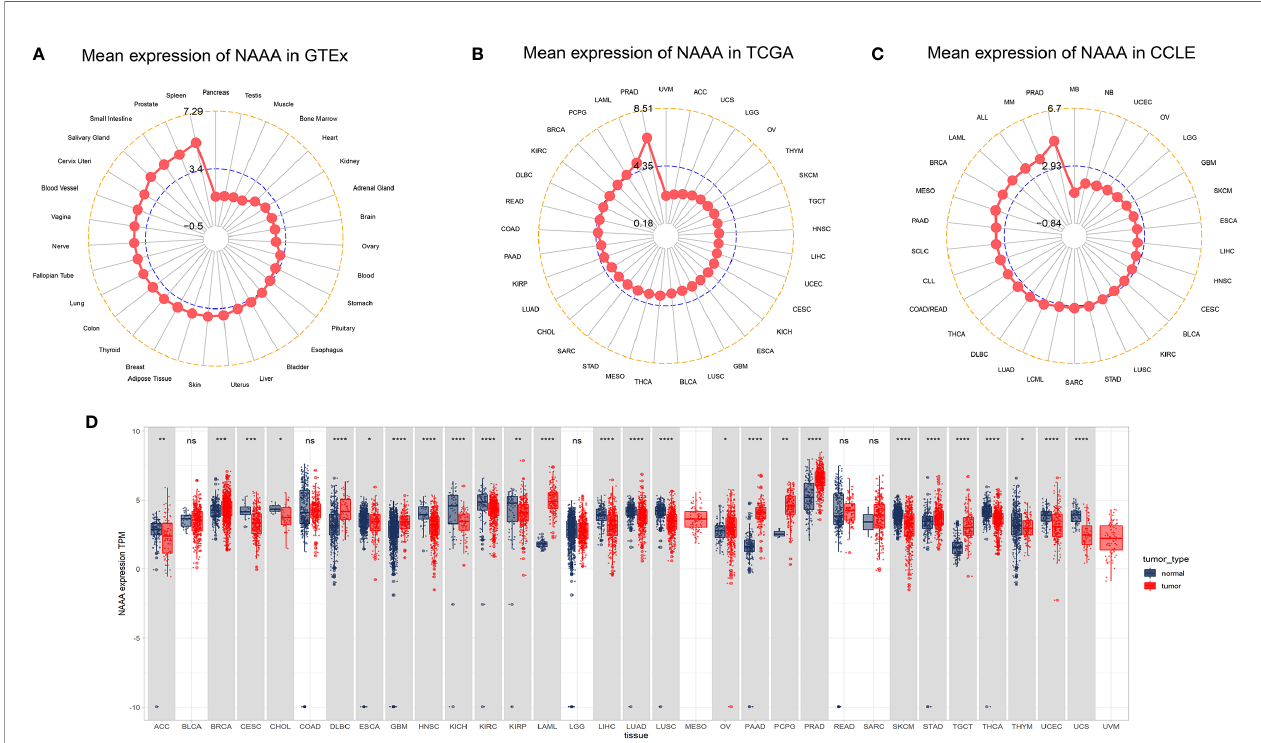
FIGURE 1 | NAAA mRNA expression levels in pan-cancer. (A) NAAA expression levels in normal tissues from GTEx database. (B) NAAA expression levels in tumor tissues from TCGA database. (C) NAAA expression levels in tumor cell lines from CCLE database. (D) NAAA expression difference between tumor tissues from TCGA database and normal tissues from the GTEx database; ns, no signi fi cance; * p < 0.05, ** p < 0.01, *** p < 0.001, and **** p <